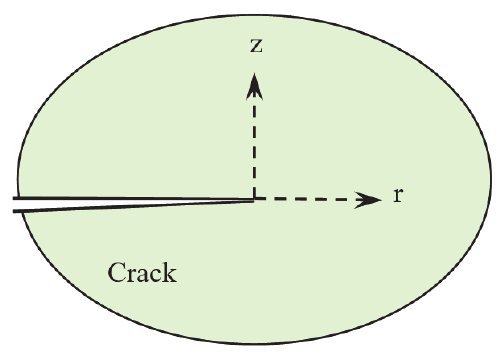
Figure 2: Local (r, z) coordinate